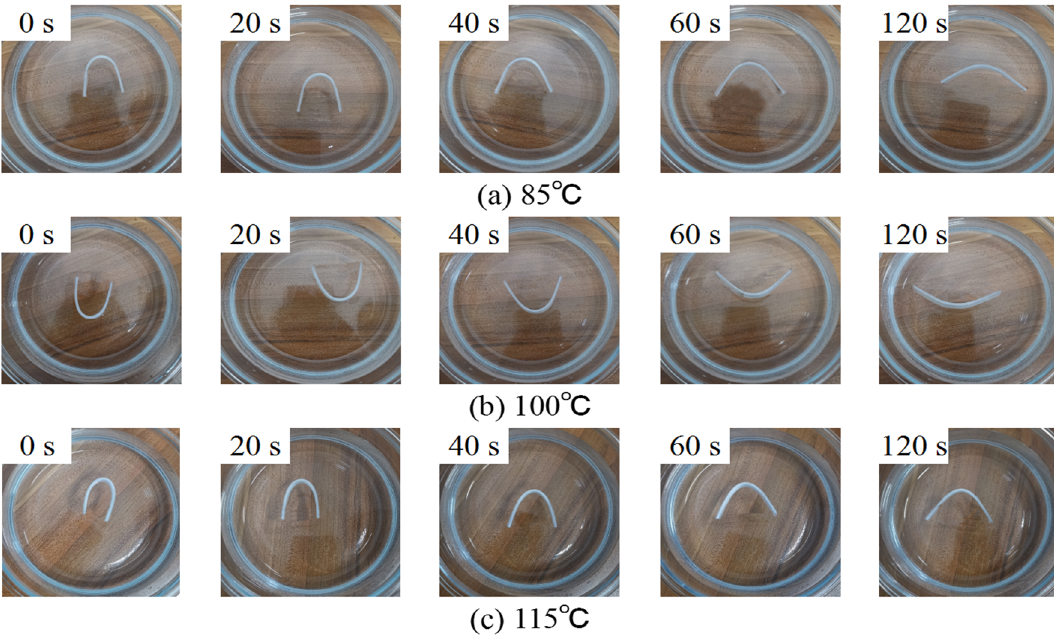
Figure 9. Representative shape recovery processes of 13PEW5CS over time at different T SW : ( a ) T SW =